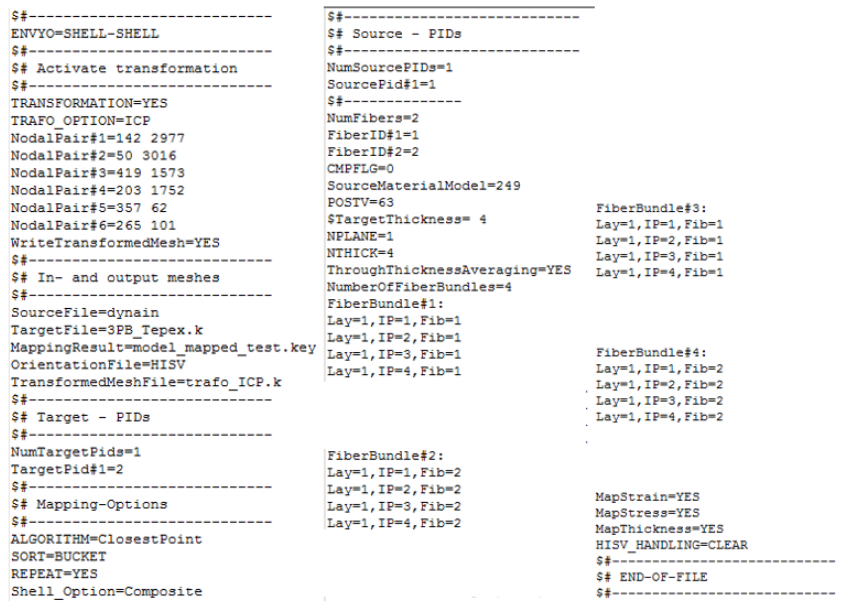
Figure 18. ENVYO—Mapping code.